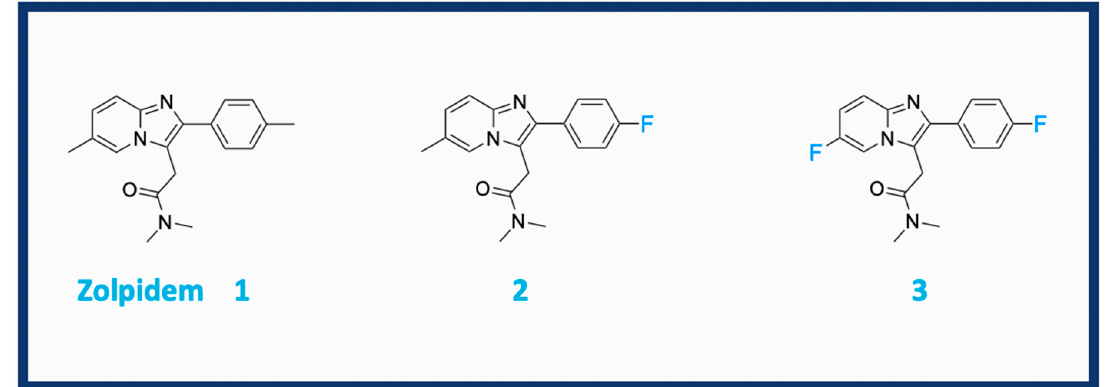
Figure 1. Chemical structure of zolpidem 1 and its fluorinated analogues 2 and 3 .